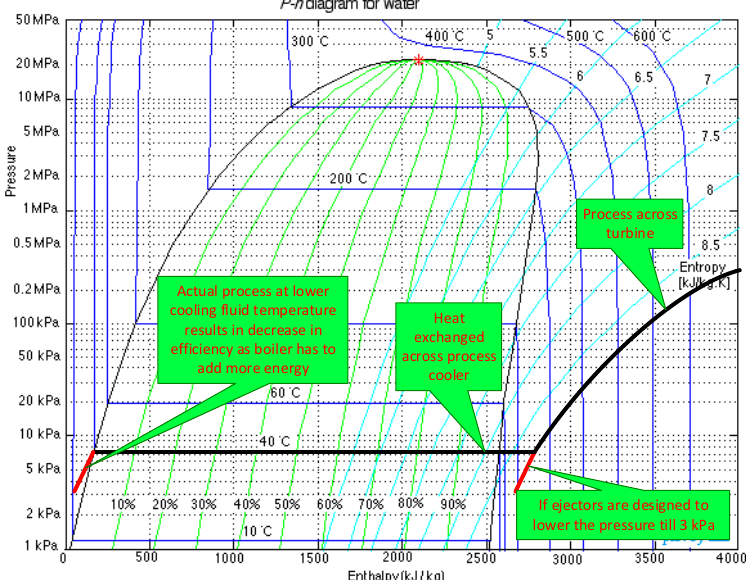
Figure 7. Pictorial process description of a practical Rankine cycle operating at temperatures lower than the designated cooling water temperature. Data adapted from NIST [40].